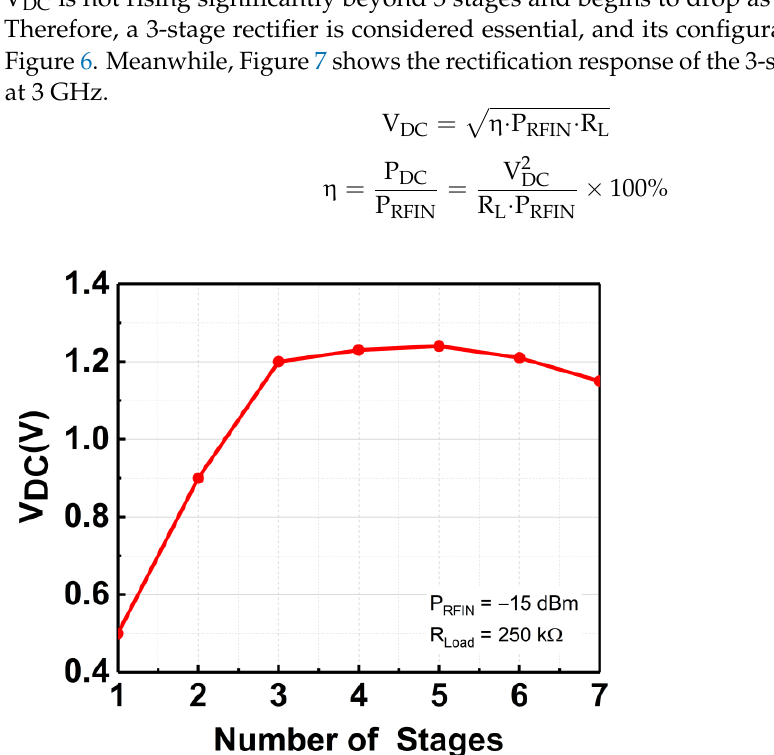
Figure 5. V DC versus rectifier stages.